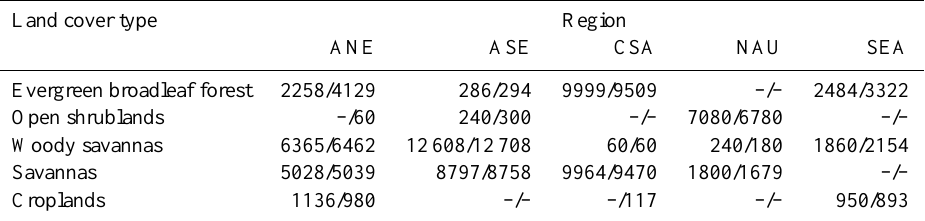
Table 2. Absolute numbers of 1 ◦ × 1 ◦ boxes included in the analysis for the estimation of fire emission rates (FERs) of NO x for the selected regions and different types of vegetation extracted from the Collection 5 MODIS Land Cover Type product. Absolute numbers obtained from the morning (early afternoon) observations are shown left (right).